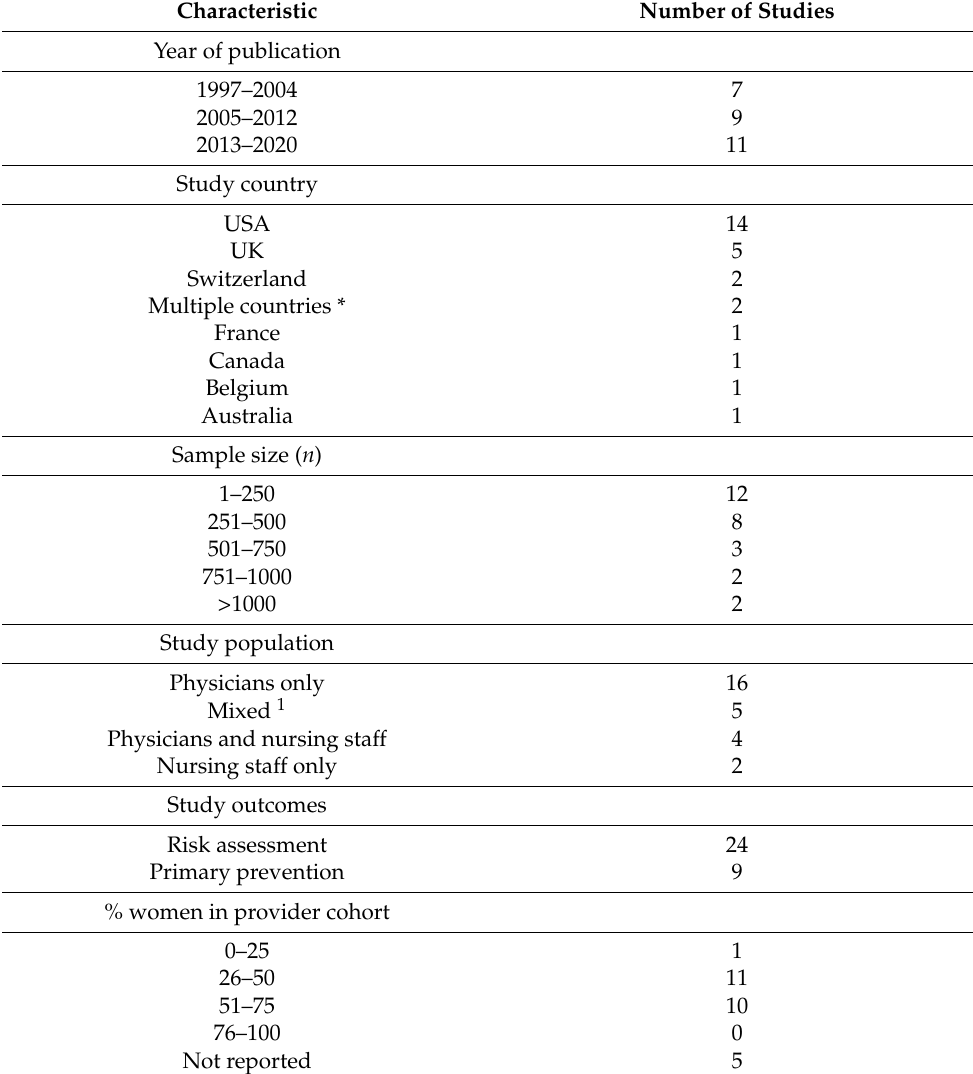
Table 1. Characteristics of studies included in the synthesis ( n =